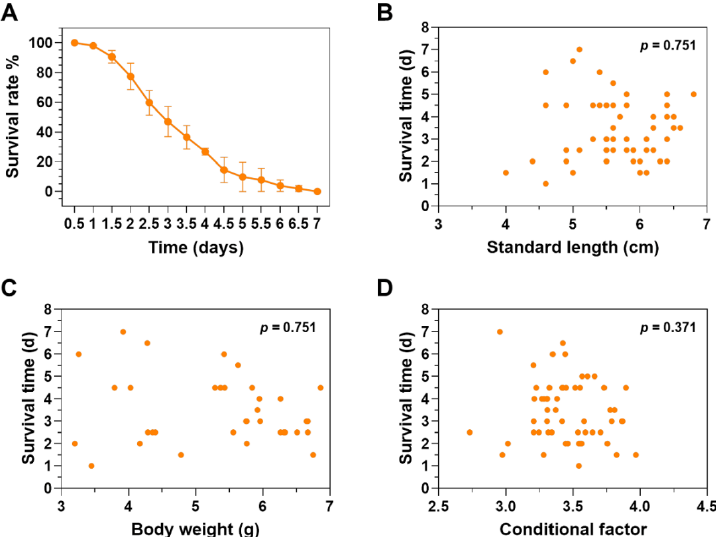
Figure 2. Survival time of the experimental fish under lethal cold stress. ( A ) Survival time of the individuals under 12 °C lethal cold stress. The error bars represent standard deviation (SD, n = 3). ( B – D ) There is no significant correlation between survival time and standard length ( B ), body weight ( C ) and conditional factor ( D ) of the experimental fish.